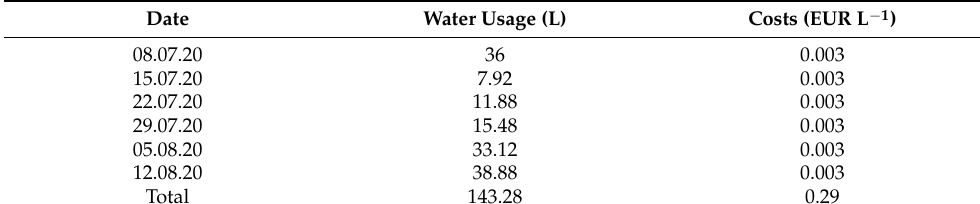
Table 6. SOF inputs: application dates, amounts and costs of irrigation.